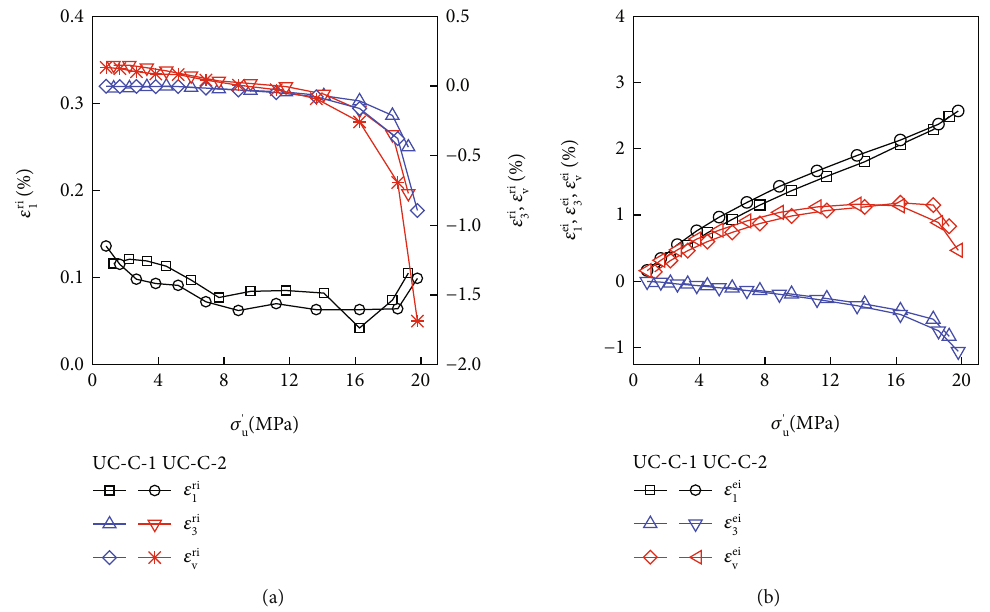
Figure 7: Relationship between unloading stress level and deformation: (a) residual strain; (b) elastic